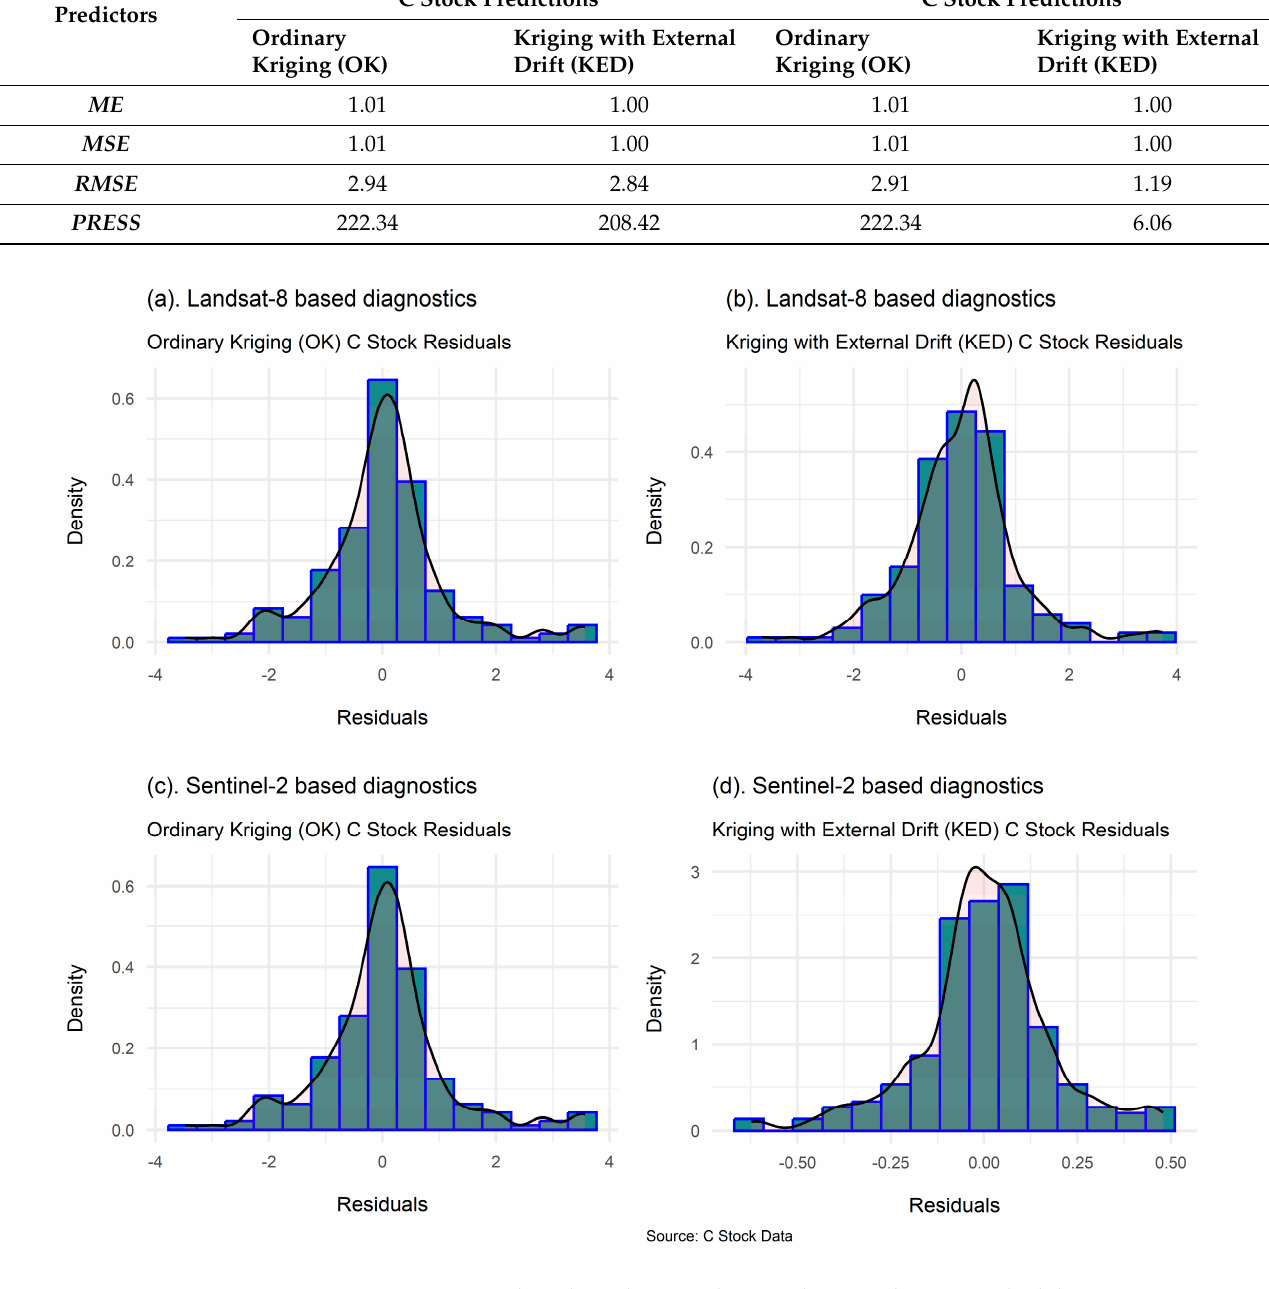
Figure 7. Frequentist-based Landsat-8 and Sentinel-2 C stock KED residual diagnostics.